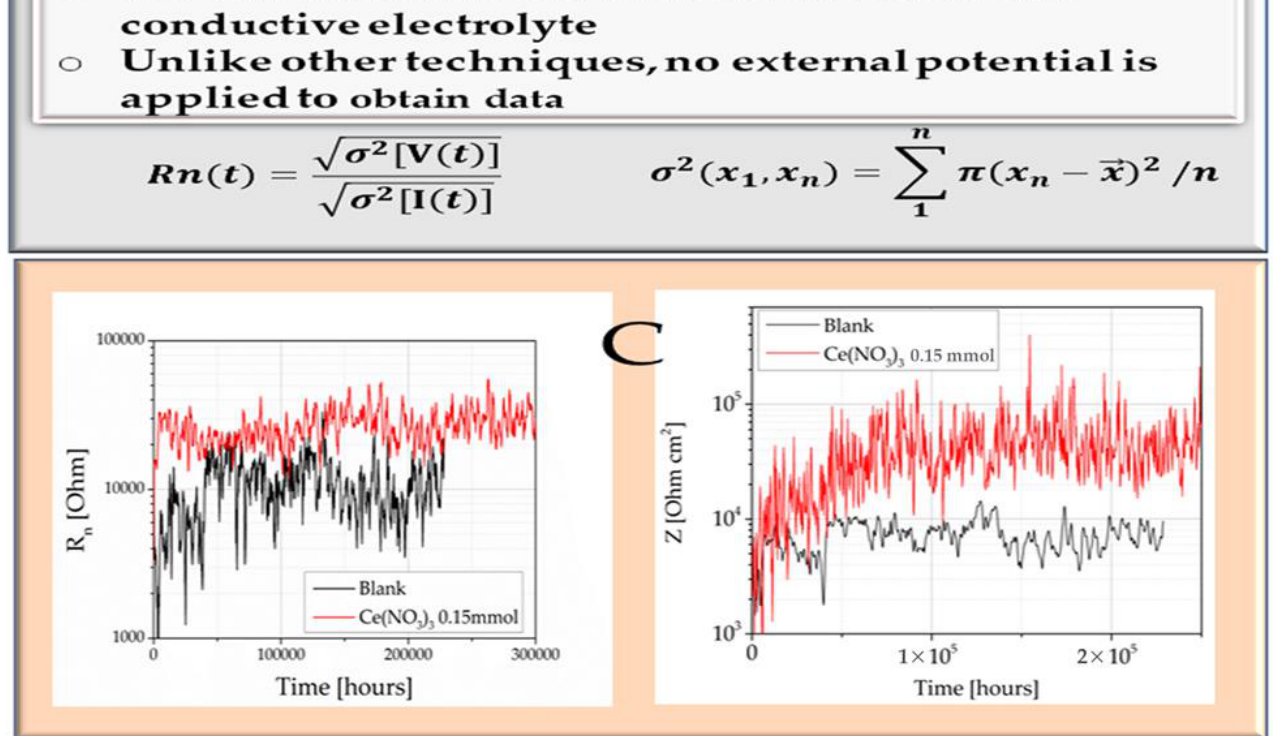
Figure 10. ( A ) Presentation of the electrochemical noise system, ( B ) R n (t) and σ n2 (x 1 , x n ) equations, and ( C ) an example of an EN measurement involving an AA 2024-T3 in a 3.5% NaCl electrolyte with and without 0.15 mmol Ce(NO 3 ) 3.